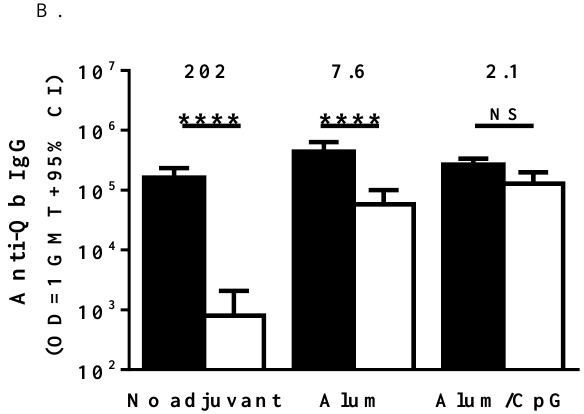
Figure 2. Anti-IgE and anti-Qb titers in WT and TLR7 KO mice. C57BL/6 mice ( n = 16/group) were immunized with 20 µ g IgE peptide Qb-VLP conjugates (10 µ g each of Qb-Y and Qb-P) without adjuvant or with alum (50 µ g) or alum/CpG (50 µ g each) on days 0, 28 and 56. Animals were bled on day 70 and plasma analyzed for anti-IgE ( A ) or anti-Qb ( B ) IgG Abs by ELISA. The fold-decrease in IgG titers between wild-type and TLR7 KO mice is indicated above the bars. The depicted data is from one animal study, but similar results were obtained in a separate study. Two and four stars indicate a significance of p < 0.01 and p < 0.0001, respectively. NS: Not significant.